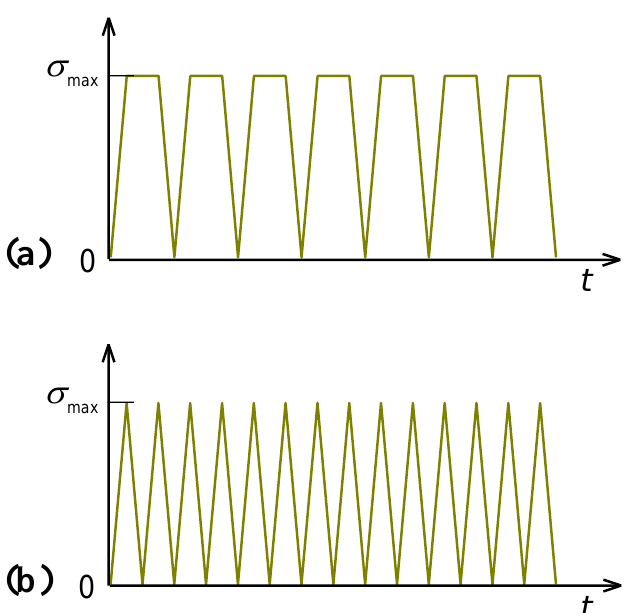
Figure 3. Schematics of loading waveforms. ( a ) Dwell fatigue loading; ( b ) Conventional fatigue loading.